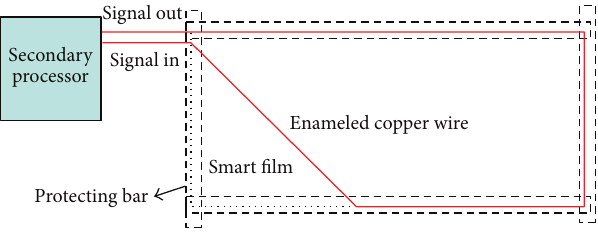
Figure 3: Road for one